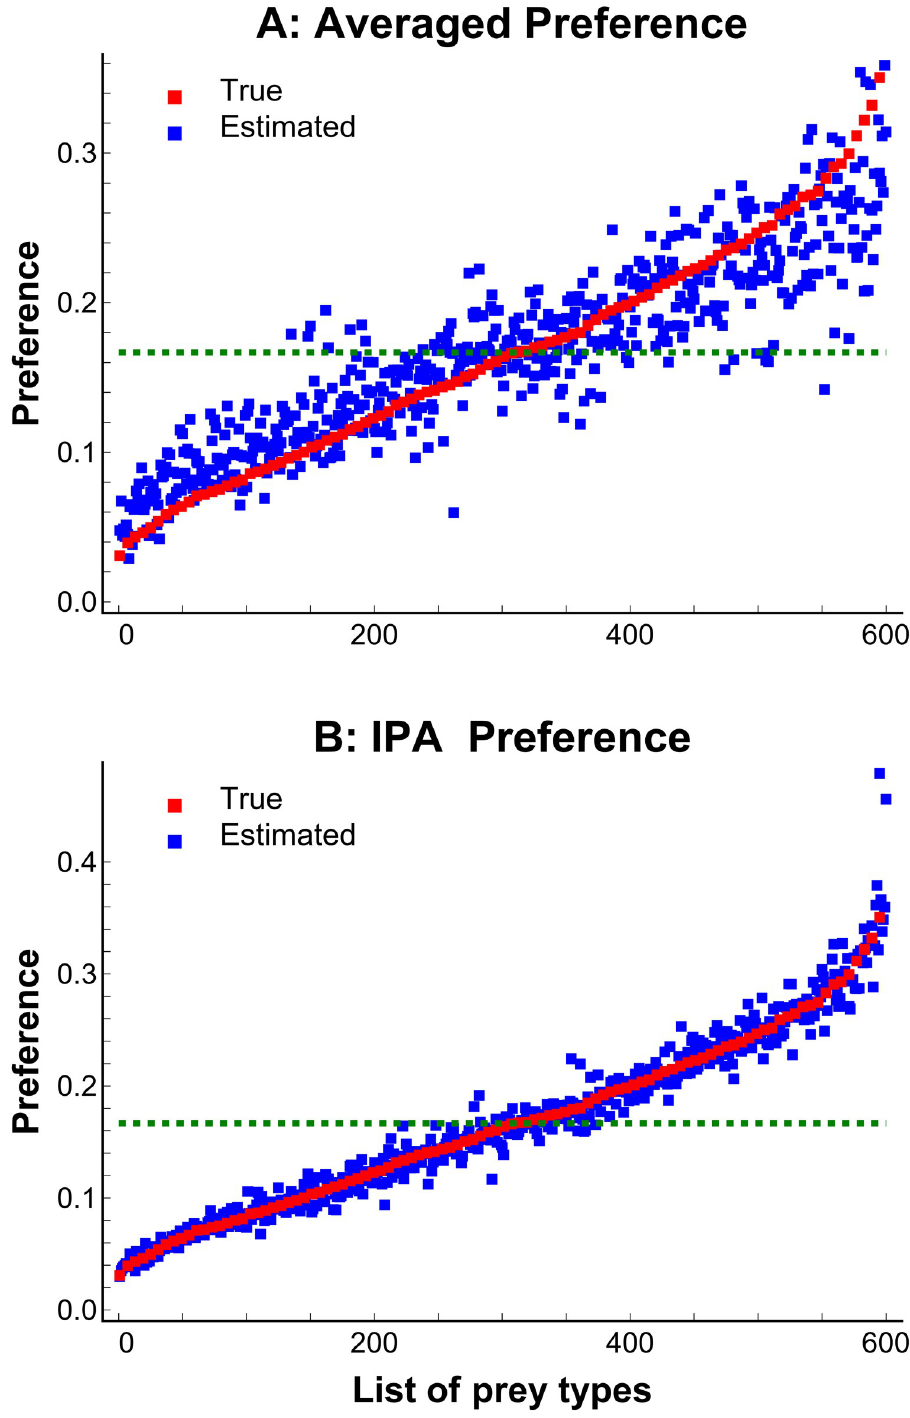
Fig 2. IPA is more accurate and precise than averaging. Simulation results comparing IPA to averaging. The list of prey types (x-axis) comprises 6 prey types x 100 replicates = 600 prey types, sorted by preference. (A) The averaged preference is simply averaging preferences over all study sites. (B) IPA is the method presented in this paper.